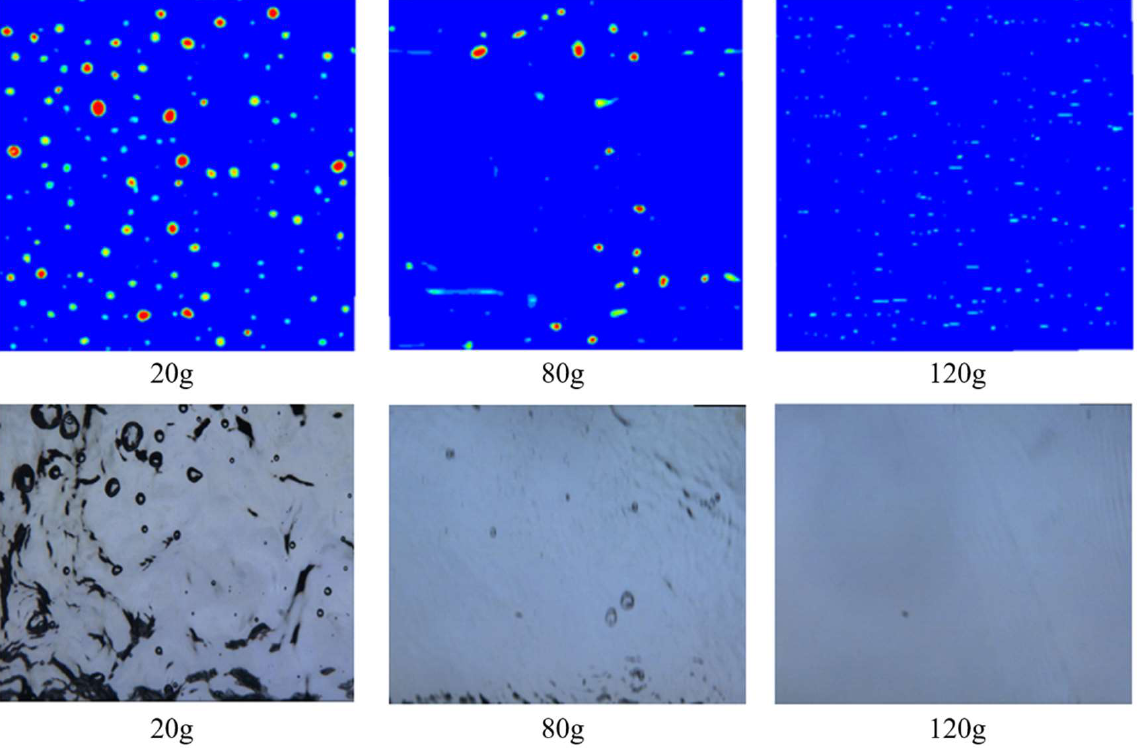
Figure 10. The bubble distribution obtained by simulations and experiments. ( q = 44,000 W/m 2 ). The boiling inhibition is observed both in simulations and experiments, in which the bubble concentration decreases with the centrifugal acceleration. The tendency of the heat transfer coefficient of the liquid film under different working conditions obtained in the experiments are taken into comparison with the theoretical predictions as shown in Figure 11.